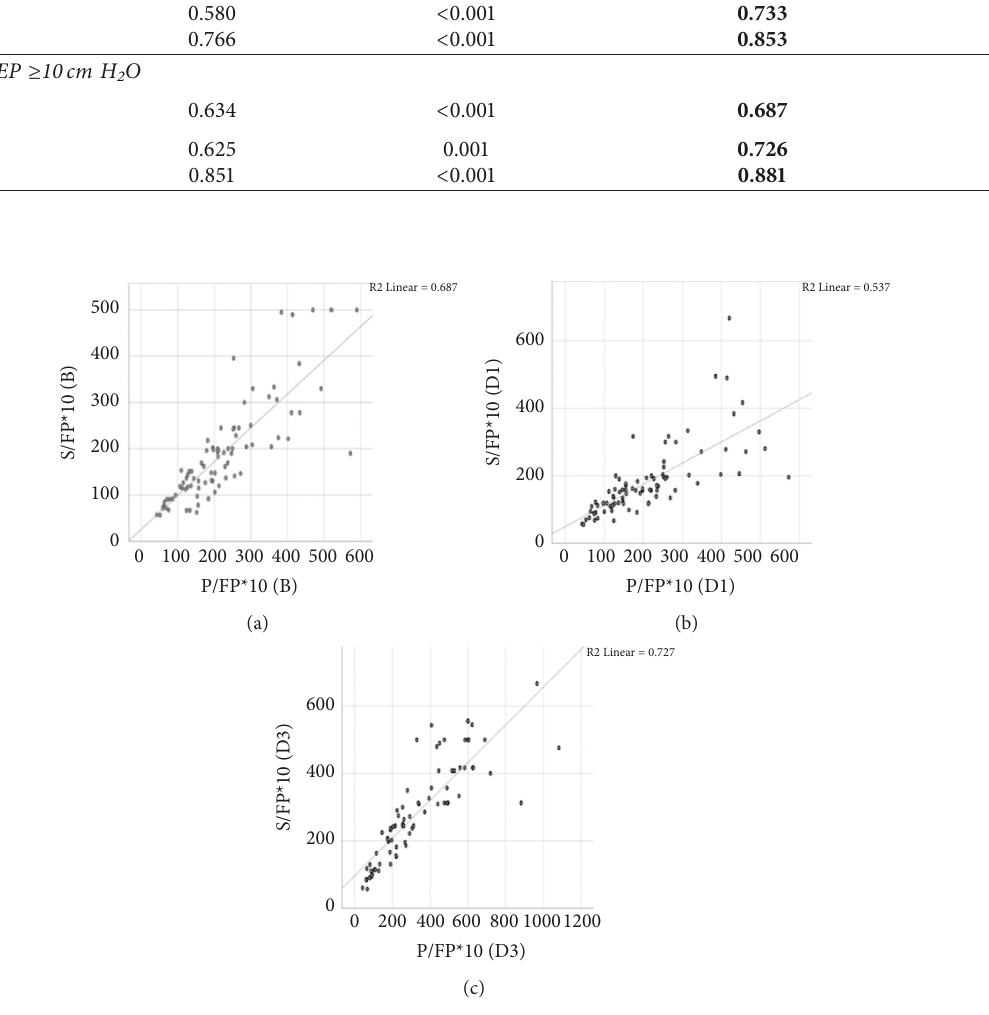
Figure 2: Scatterplot depicting correlation of S/FP ∗ 10 and P/FP ∗ 10 at all levels of PEEP at baseline (Panel (a)), day one (Panel (b)), and day three (Panel (c)). PEEP: positive end-expiratory pressure.